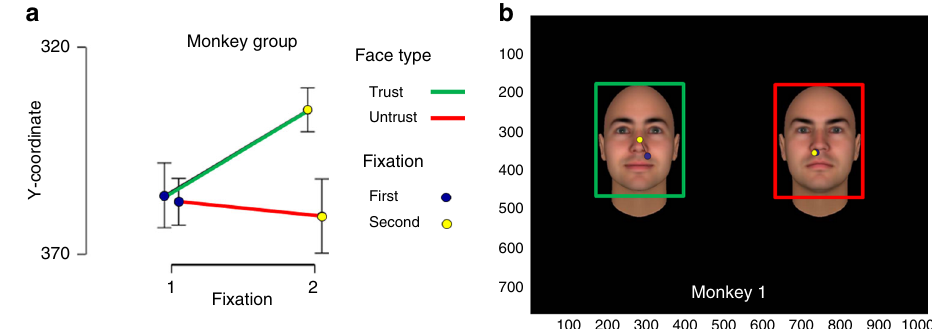
Fig. 3 Fixations sequence analysis. a Graph shows monkeys ’ Y coordinates of fi rst and second fi xations weighted by duration ( fi rst in blue, second in yellow) and type of face (trustworthy in green, untrustworthy in red); Fixations closer to the eye region are closer to y = 300. The location of the fi rst fi xation on the face is not different for the trustworthy and untrustworthy face but the location of second fi xation is closer to the eye region only for the trustworthy face, ANOVA, p = 0.027. Error bars indicate S.E. M. across 8 subjects. b Position of the fi rst (in blue) and second fi xations (in yellow) over the trustworthy face (left, green ROI) and untrustworthy faces (right, red ROI) for monkey 1. Faces are selected from the Todorov ’ s Database of